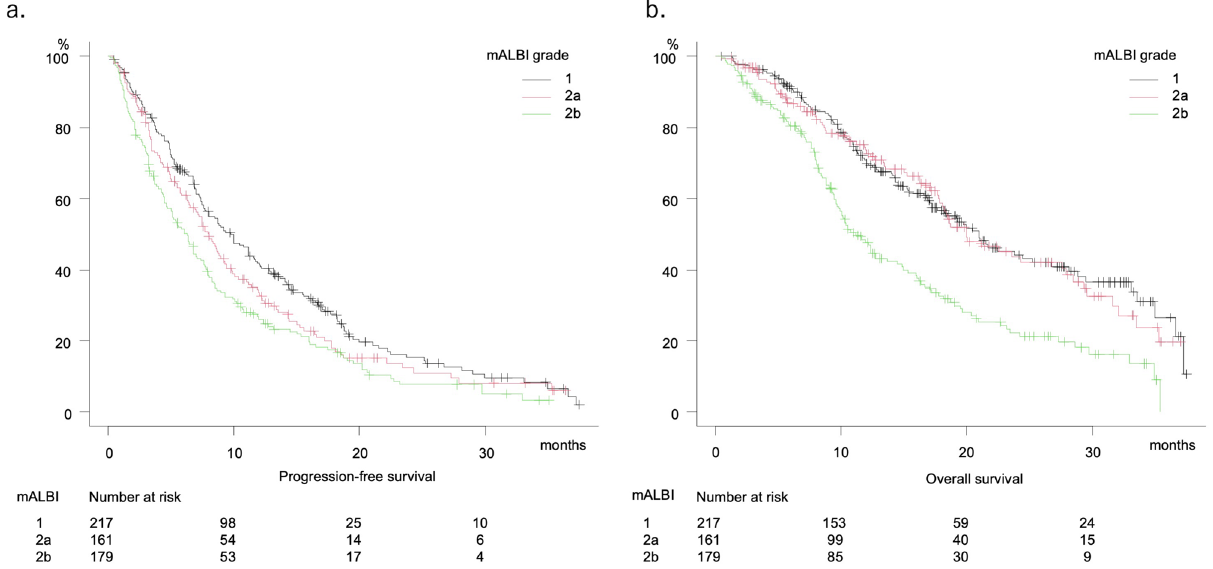
Figure 3. Progression-free and overall survival according to modified ALBI grade. ( a ) Progression-free survival divided by mALBI grade. mALBI 1 (median 9.8 months, 95% CI 7.8–11.6), mALBI 2a (median 8.0 months, 95% CI 6.6–9.3), mALBI 2b (6.3 months, 95% CI 4.8–7.4) (P = 0.002). ( b ) Overall survival divided by mALBI grade. mALBI 1 (median 21.0 months, 95% CI 17.2–26.8), mALBI 2a (median 20.0 months, 95% CI 17.8–27.9), mALBI 2b (median 11.2 months, 95% CI 9.7–14.5) (P <